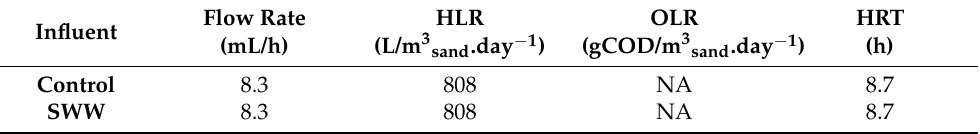
Table 1. Percentage calcium in sand from cores taken from biosand reactors treating winery